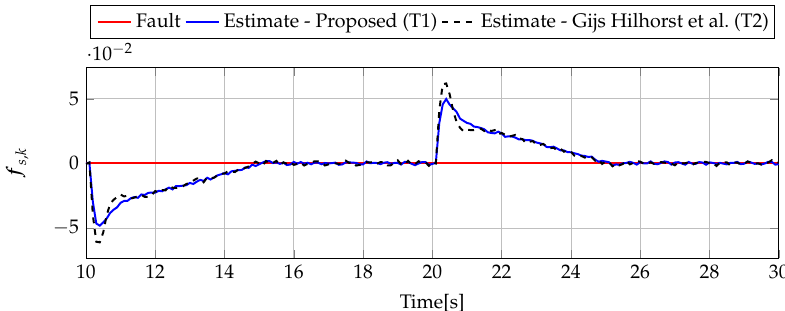
Figure 4. Sensor fault estimate for the fault-free case (for t = 10, . . . ,30) with Theorem 1 (T1) and Theorem 2 (T2) based on [39] for disturbance signal w 1, k .